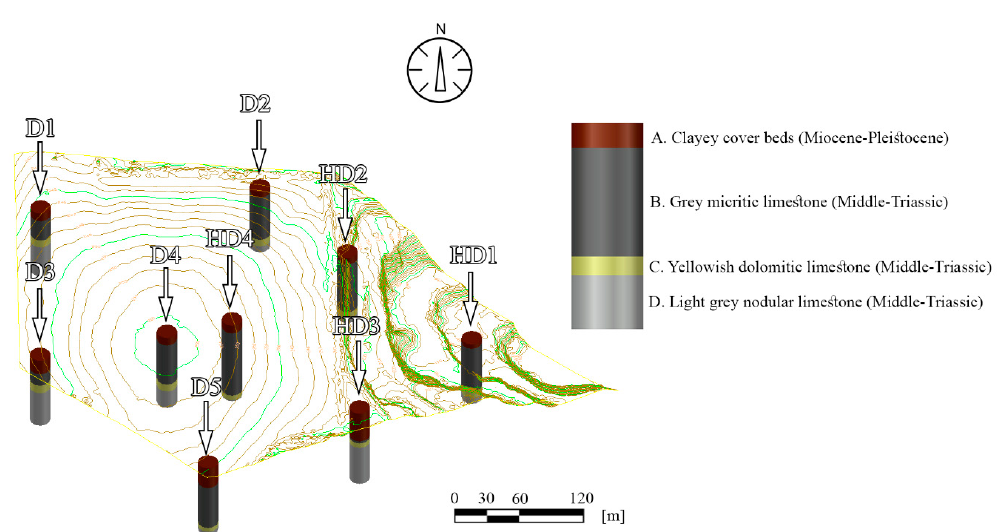
Figure 10. 3D topography of the area showing previous core drillings (HD) and recent core drilling (D), The idealised lithologic column of Triassic limestone reserve (B-D) and cover beds (A) are also shown. The lithologic units (A-D) representing different qualities were used in the reserve calculations.